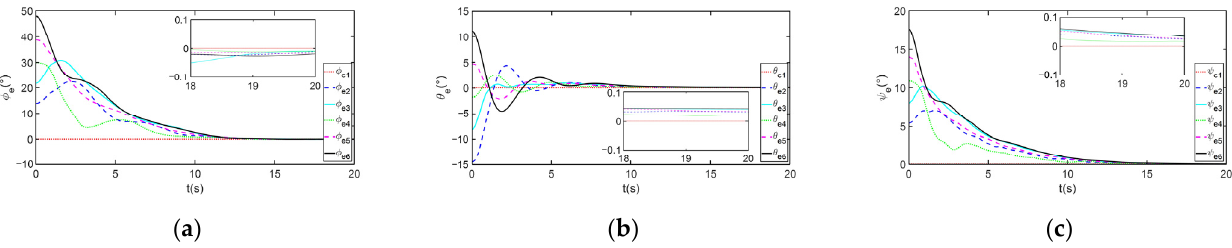
Figure 8. The attitude tracking synchronization error of the swarm utilizing SRP systems or NP systems: ( a ) Roll error; ( b ) Pitch error; ( c ) Yaw error.